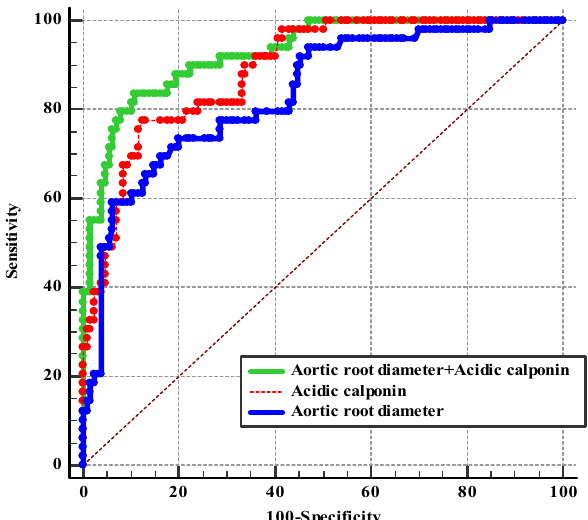
Figure 5. ROC curve showing the diagnostic value of acidic calponin for A-AAS.